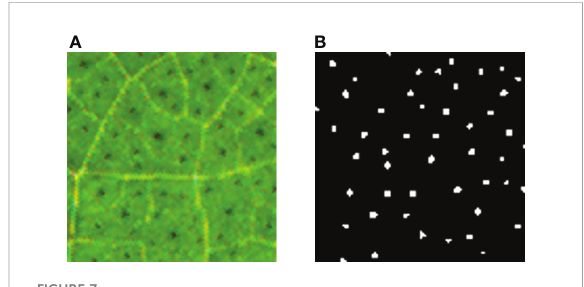
FIGURE 7 Segmentation results. (A) Original image; (B) Segmented result.